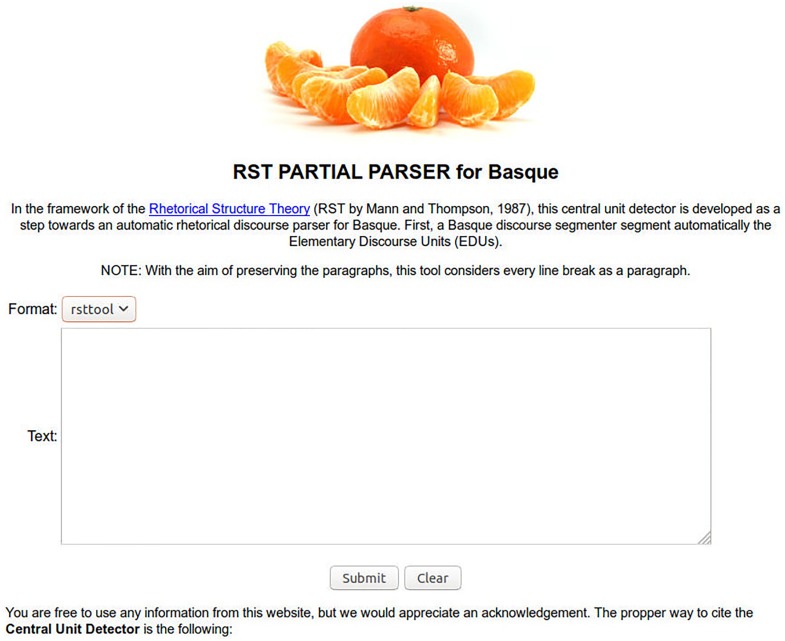
The partial parser.